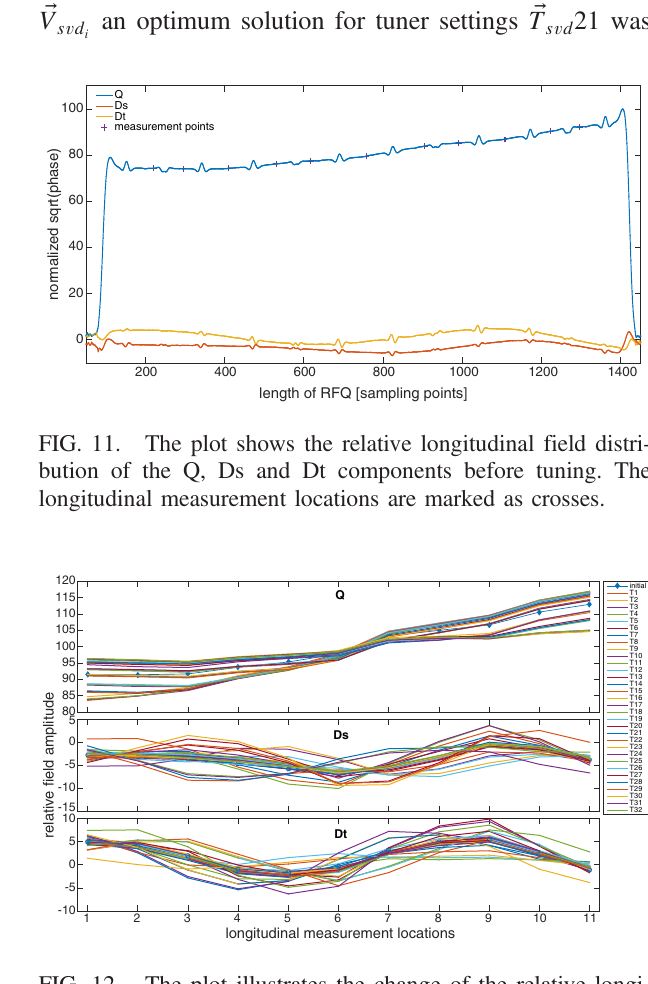
FIG. 10. The top three plots show several predictions for field compensation for Q, Ds, and Dt components separately. The bottom plot illustrates the corresponding tuner settings.